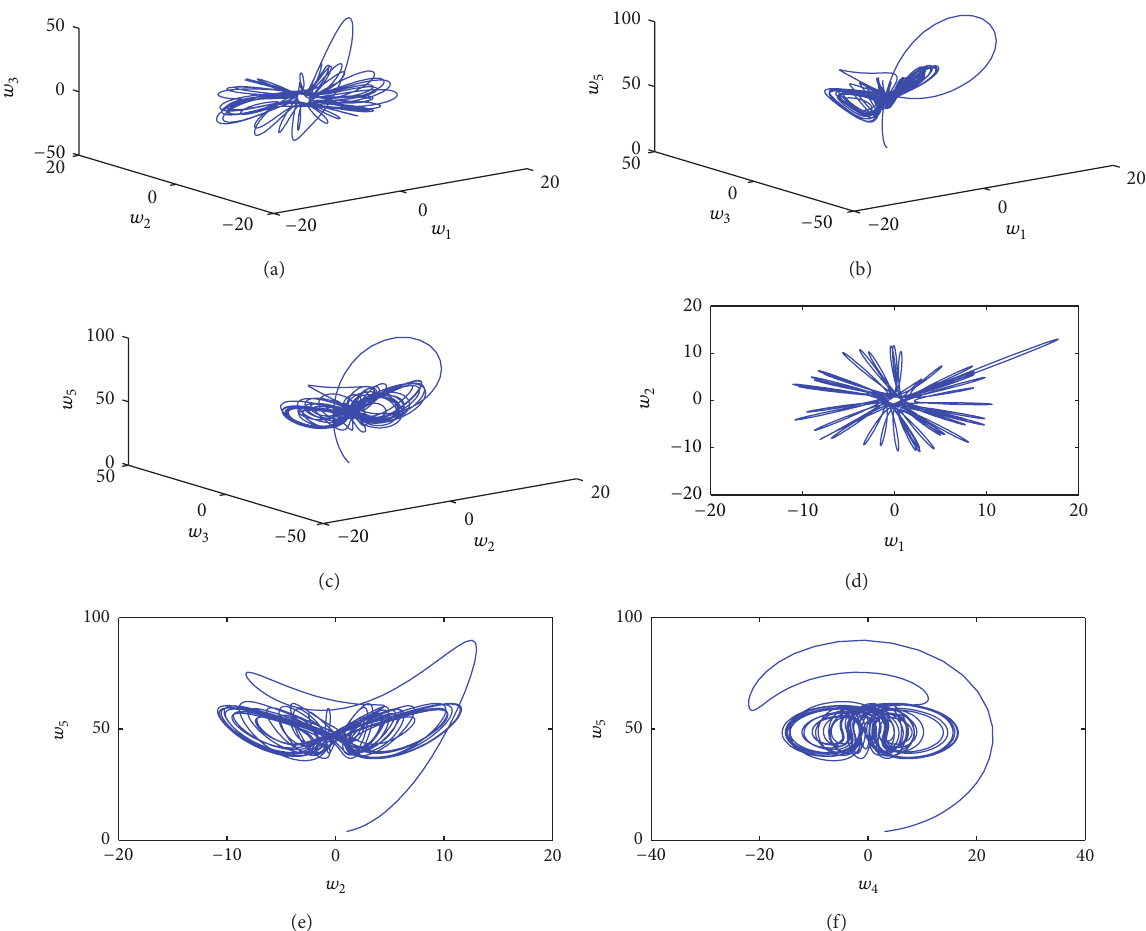
Figure 2: Chaotic attractor for system (7). (a)–(c) Projections in 3D space; (d)–(f) projections in 2D